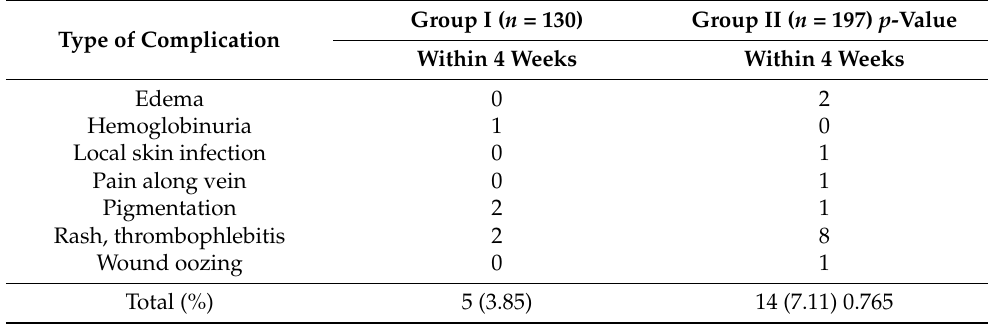
Table 5. Recanalization rates between MOCA (Group I) and combined EVLA and MOCA (Group II). Recanalization (%)